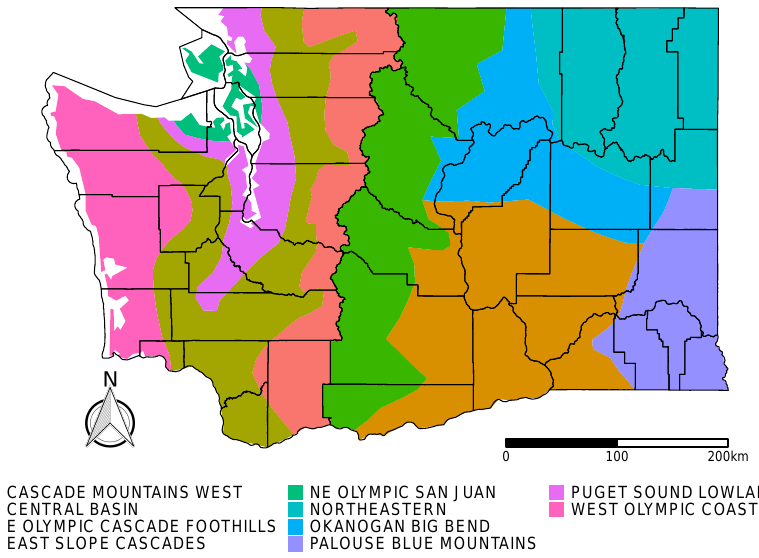
Figure 1. Map of NOAA climate divisions in